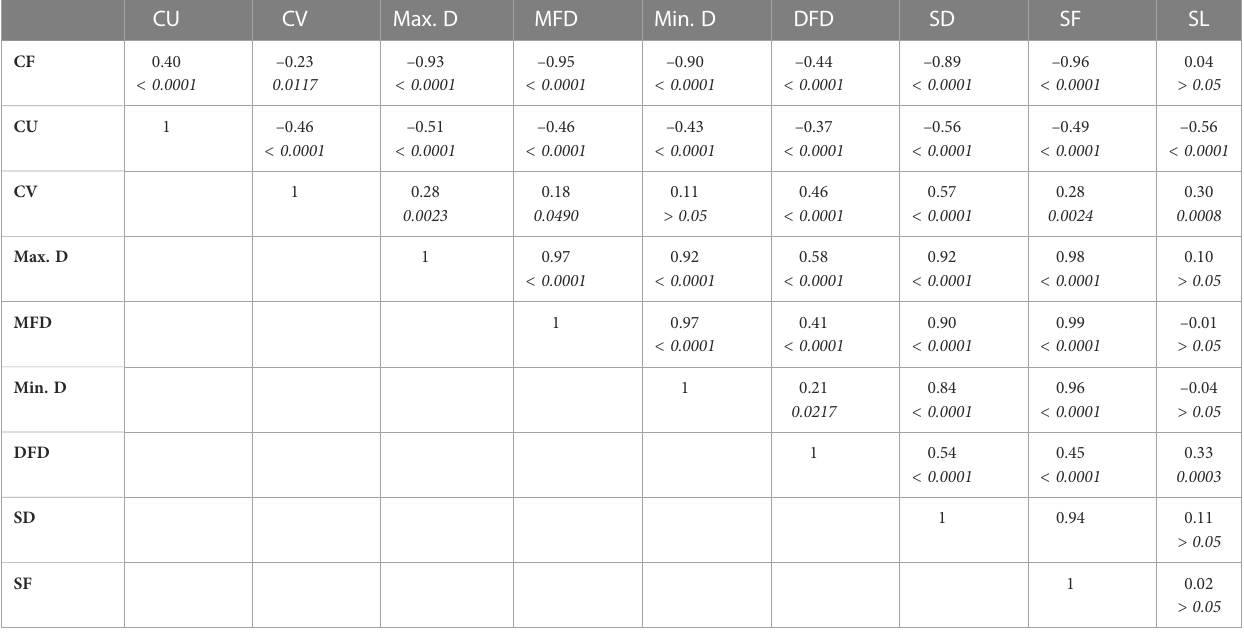
CU CV Max. D MFD Min.